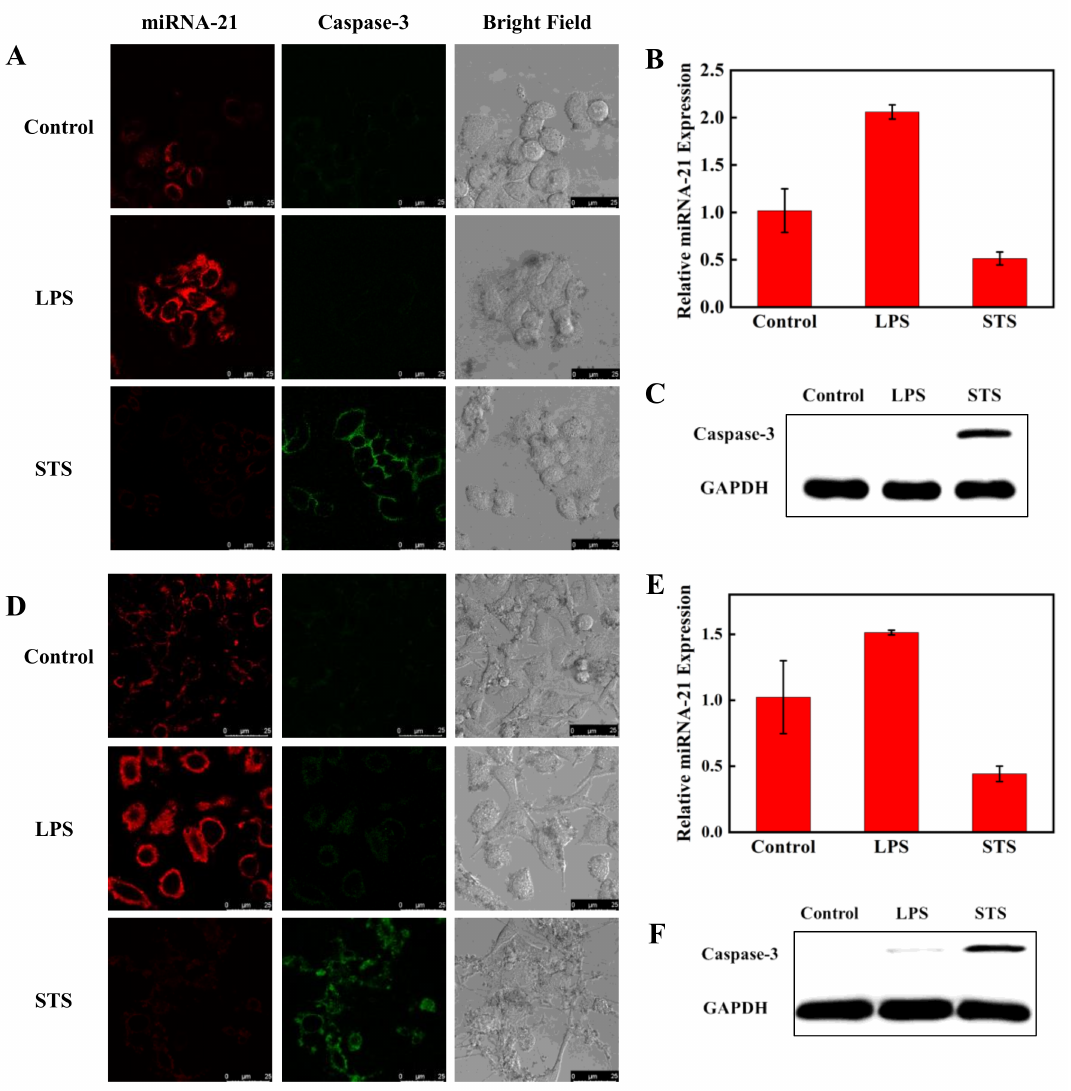
Figure 6. Confocal fluorescence images of miRNA-21 and caspase-3 in Hela cells ( A ) and A549 cells ( D ). The cells were treated with LPS to increase miRNA-21 expression and with STS to increase caspase-3 expression. The treated and untreated cells were incubated with the nanoprobe for 4 h at 37 ◦ C. The red and green channels were observed with 488 and 633 nm lasers, respectively. Scale bar is 25 µ m. Detection of miRNA-21 level by RT-PCR in Hela cells ( B ) and A549 cells ( E ) after treatment with LPS and STS. The Western blot assay of caspase-3 expression in Hela cells ( C ) and A549 cells ( F